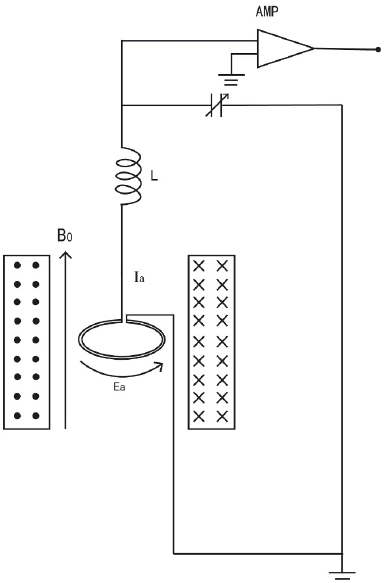
Figure 4 . The schematic diagram of experimental setup for case I. For case II, the external solenoid is replaced by horizontally placed parallel plates.